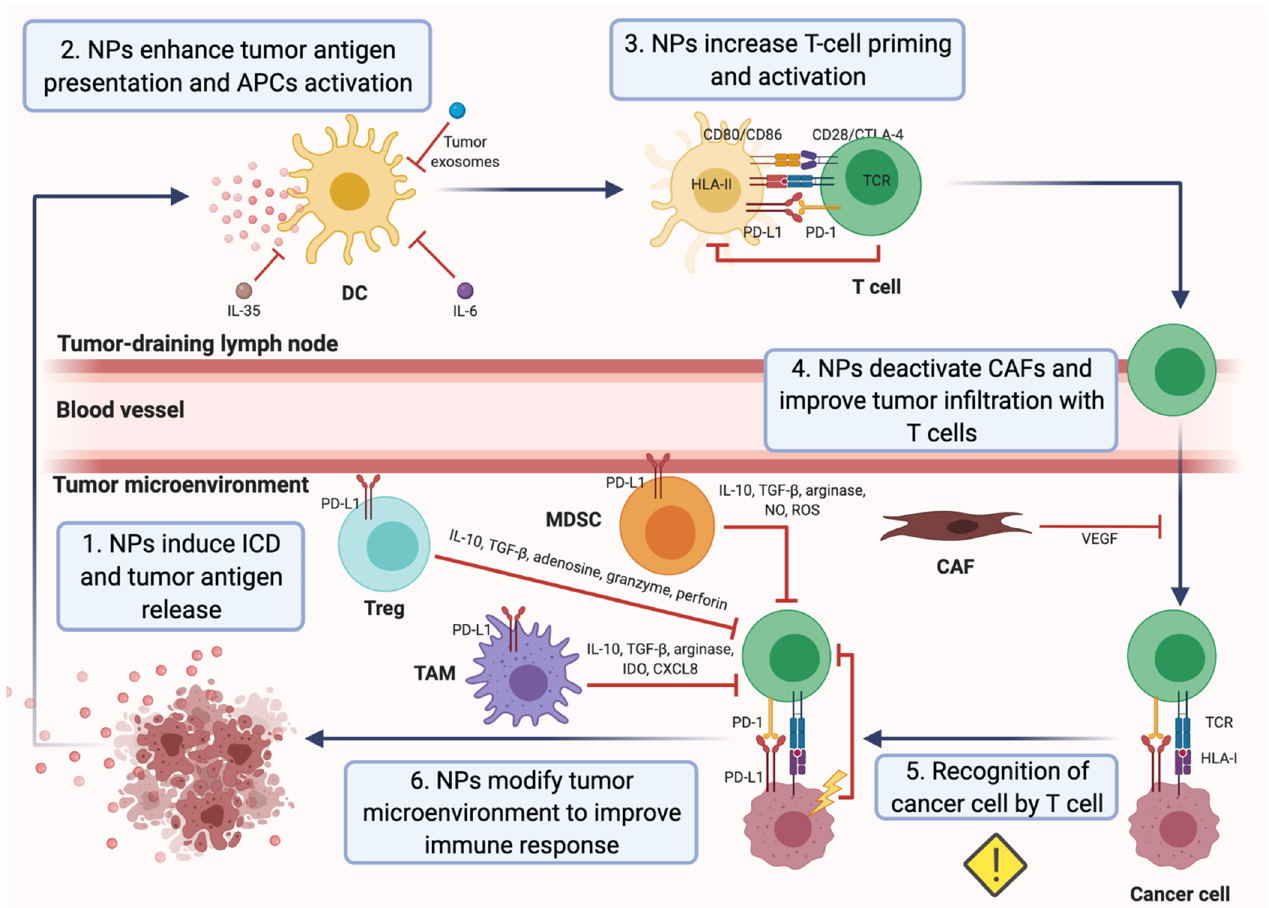
Figure 2. Cancer immunity cycle and nanoparticle (NP)-based strategies to overcome mechanisms of immune escape. NP-based approaches can ameliorate various mechanisms of immune